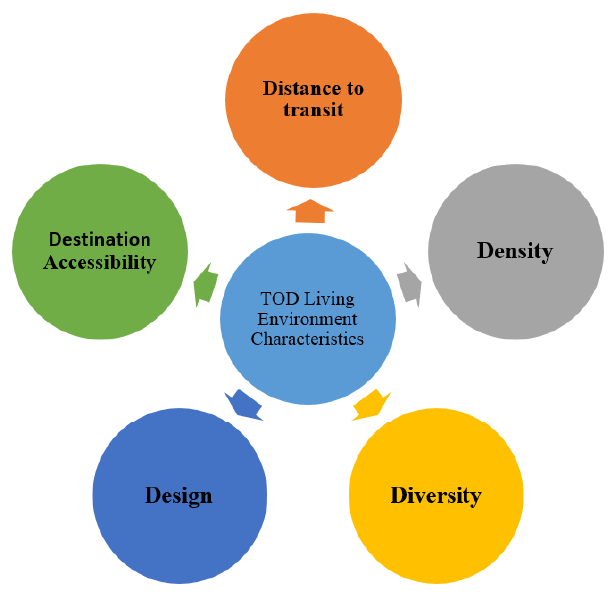
Figure 2. The five characteristics of the TOD living environment.